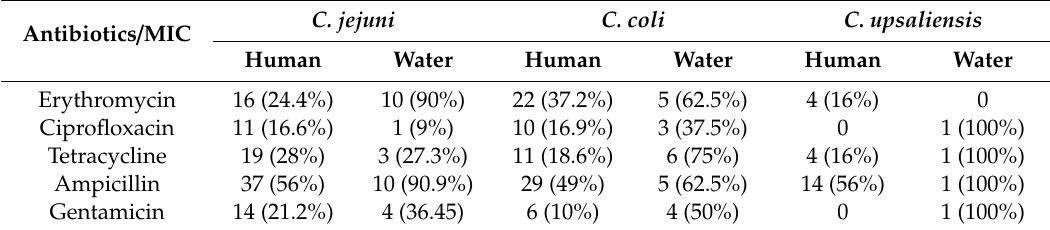
Table 5. Distribution of MIC amongst the clinical Campylobacter isolates.